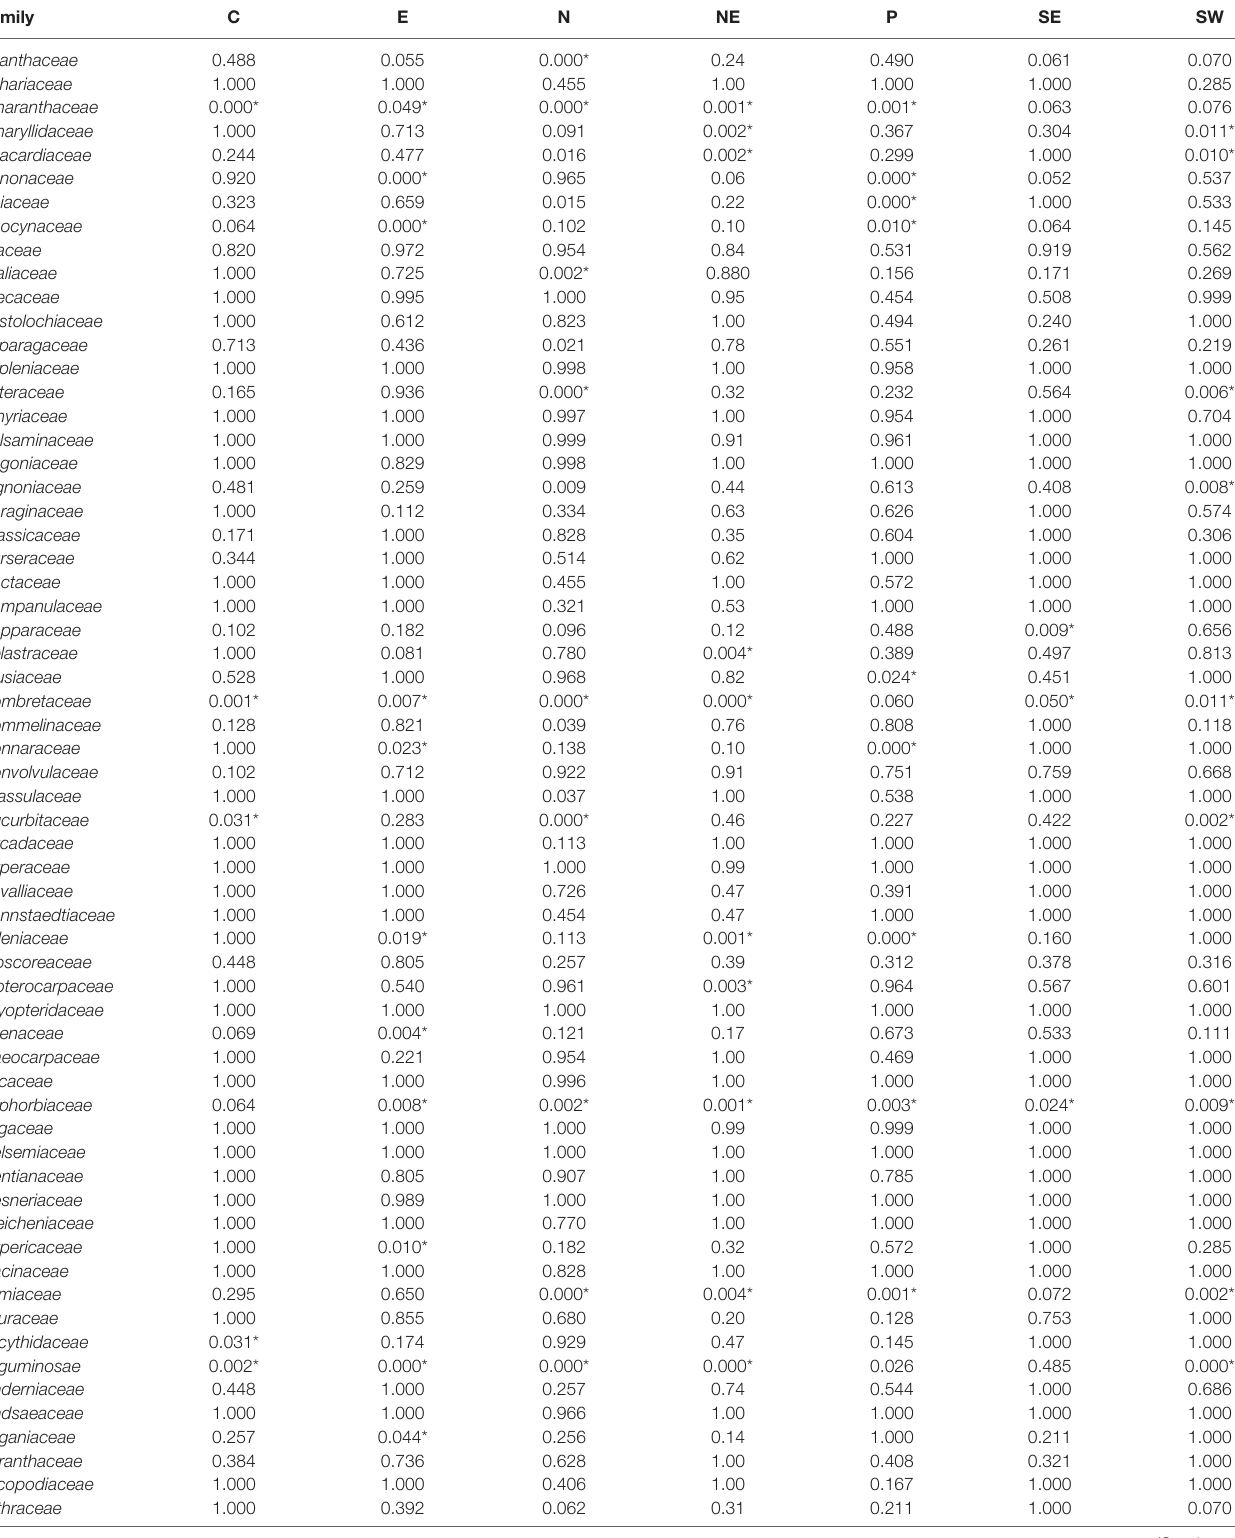
TaBle 3 | Binomial probabilities of the plant families with higher numbers of medicinal species than expected under the null model of a perfect relationship with family size. Family C e N Ne P se sW